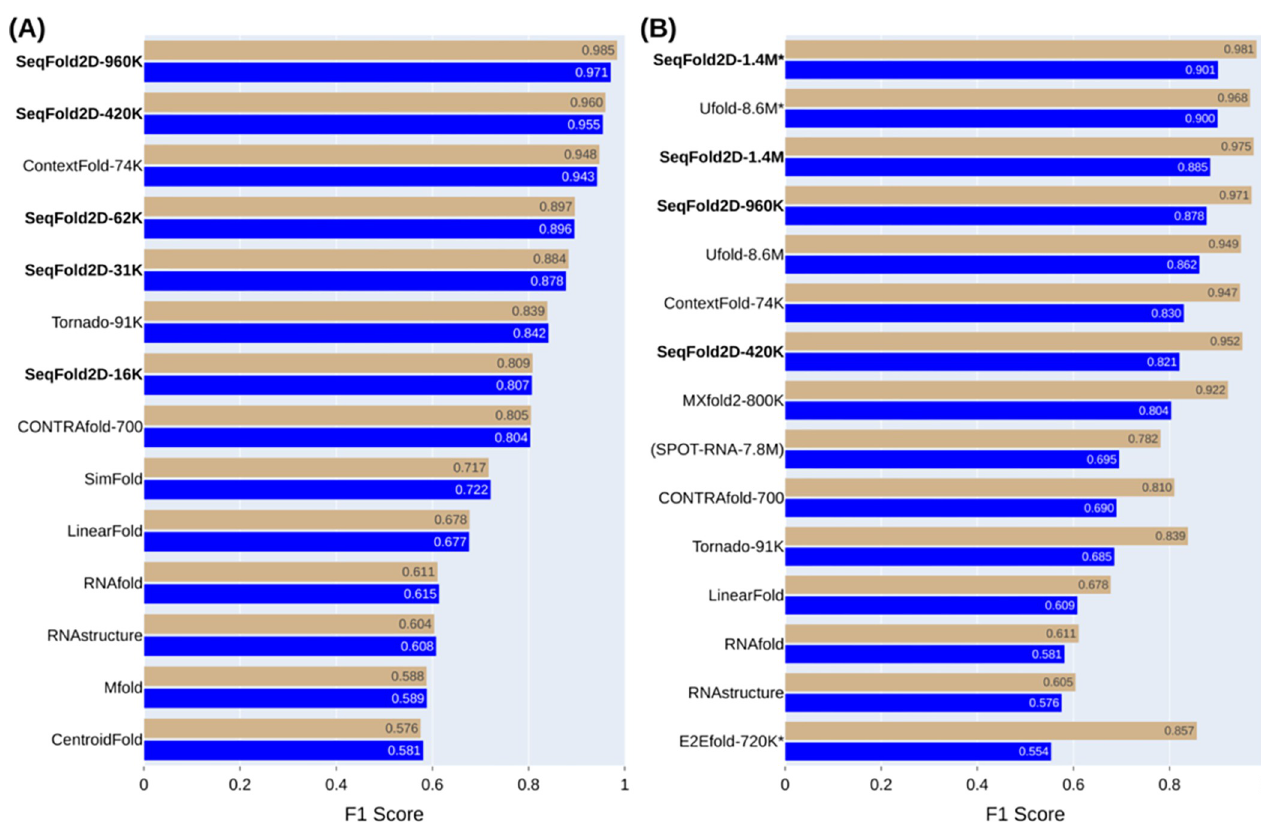
Fig 2. The mean F1 scores on the TR (tan) and TS (blue) sets by SeqFold2D and selected DL and traditional models in two different dataset setups. (A) Both TR and TS sets are from Stralign NR100. (B) TR from Stralign NR100 and TS from ArchiveII NR100.The models are sorted by their TS F1 scores. The names for the learning-based models are appended with the number of parameters and the trailing asterisk indicates the use of post-processing. At the end of each bar shows the F1 value. All learning-based models except SPOT-RNA are re-trained.